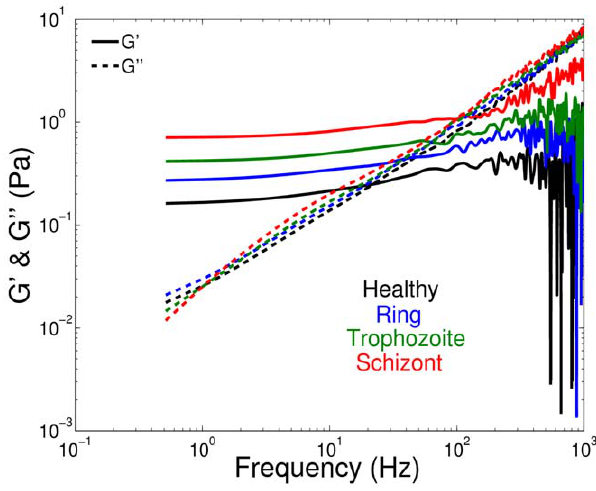
Figure 8. Components ( G ’ and G ’’ ) of the three-dimensional complex modulus for healthy RBCs and Pf-RBCs at different stages of parasite development. These measurements were obtained in simulations by monitoring membrane thermal fluctuations at T ~ 23 o C . The shear moduli of Pf-RBCs for different stages are given in Table 1. The bending stiffness and the membrane viscosity in all cases are set to 2 : 4 | 10 { 19 J and 0 : 022 Pa : s , respectively.